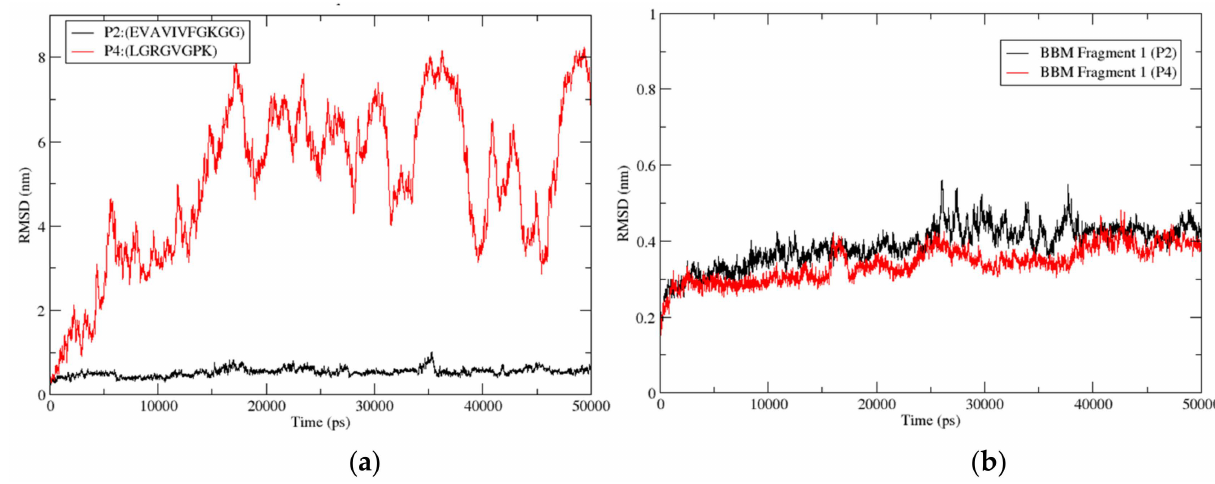
Figure 8. ( a ) Root mean square deviation (RMSD) for peptides P2 (dock10) and P4 was calculated from the protein-peptide complex. ( b ) Root mean square deviation (RMSD) for protein BBM Fragment 1 calculated from the protein-peptide complex. Figures are generated using the xmgrace tool of